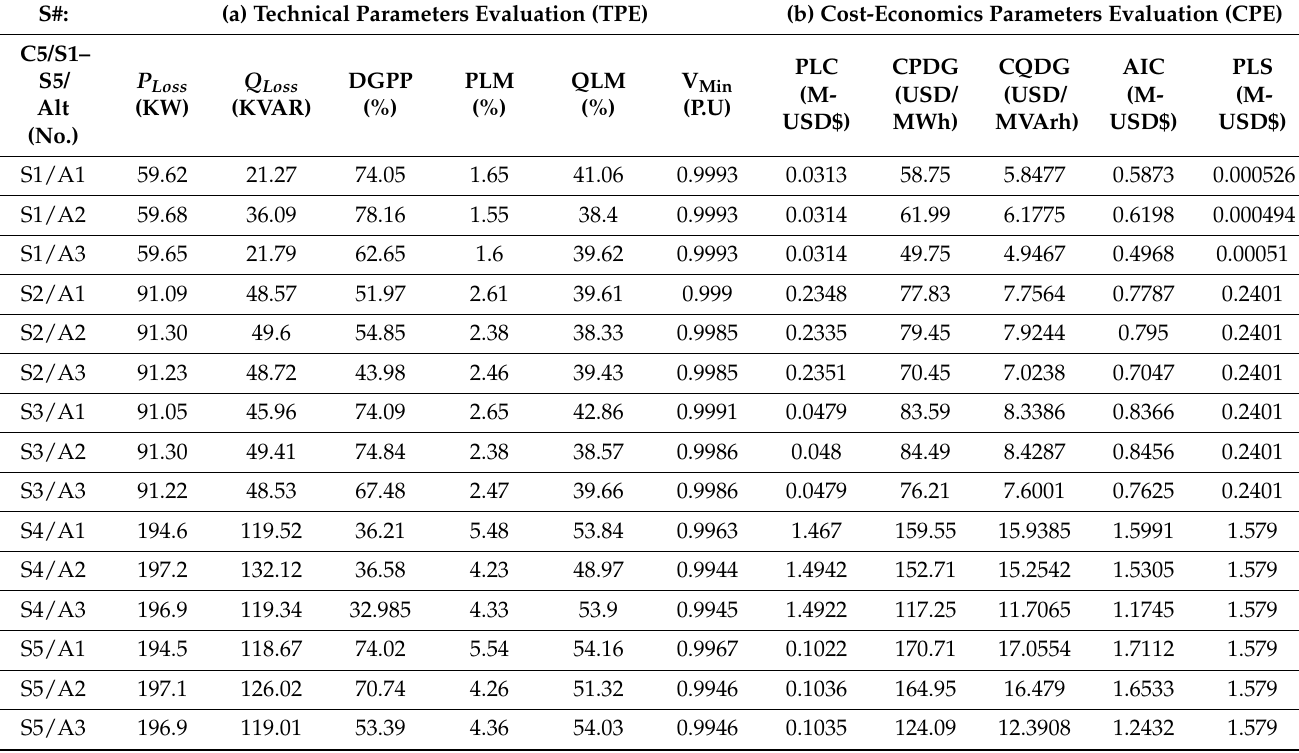
Table 22. TPE/CPE evaluations in C5/S1–S5 for the 75-bus MDN NUST_MG for DG only.